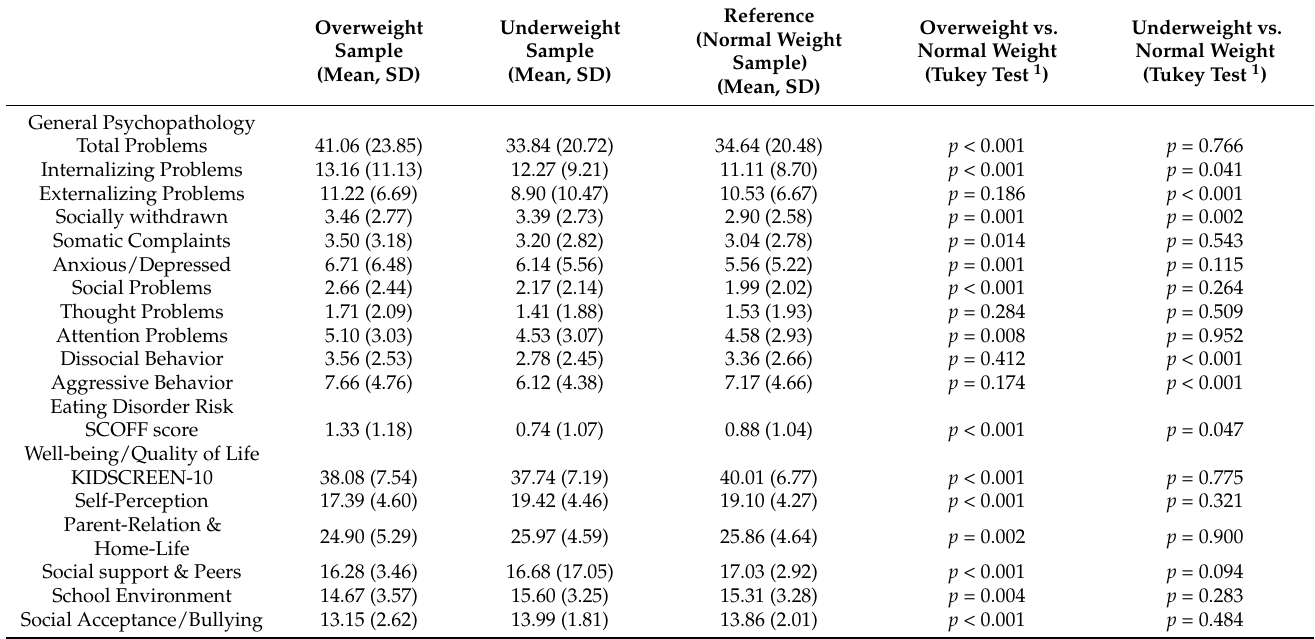
Table 2. Differences in psychopathology, eating disorder risk and well-being scores of overweight and underweight adolescents compared to a normal weight reference